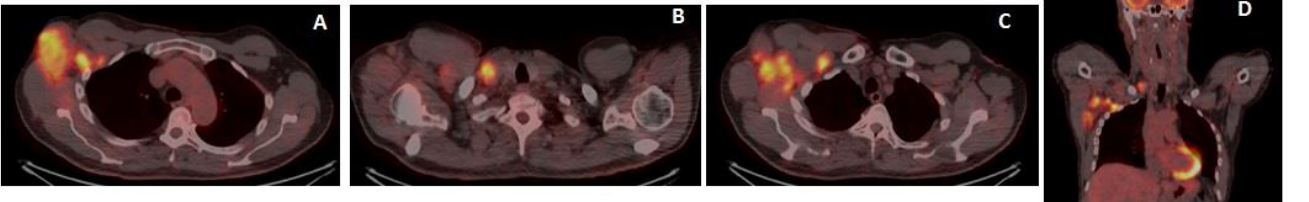
Figure 5. 18-FDG-PET/CT at baseline (axial and coronal sections), increased tracer uptake in the right axillary adenopathy mass (SUV max 9.7) ( A ), in the right supraclavicular adenopathy (SUV max 7.6) ( B ) and in multiple axillary adenopathies (level I – III) ( C , D ).